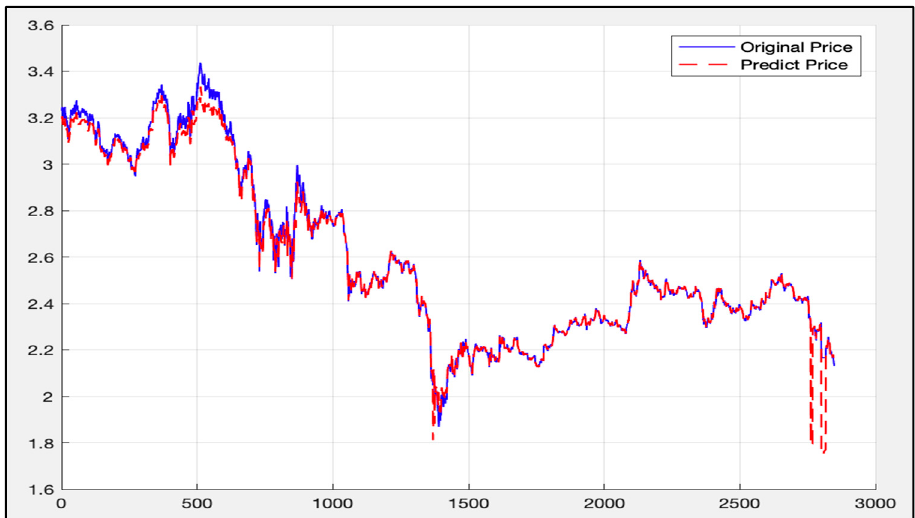
Figure 27. Comparison of LSTM-SVR II prediction results with actual results (first 2850 data).